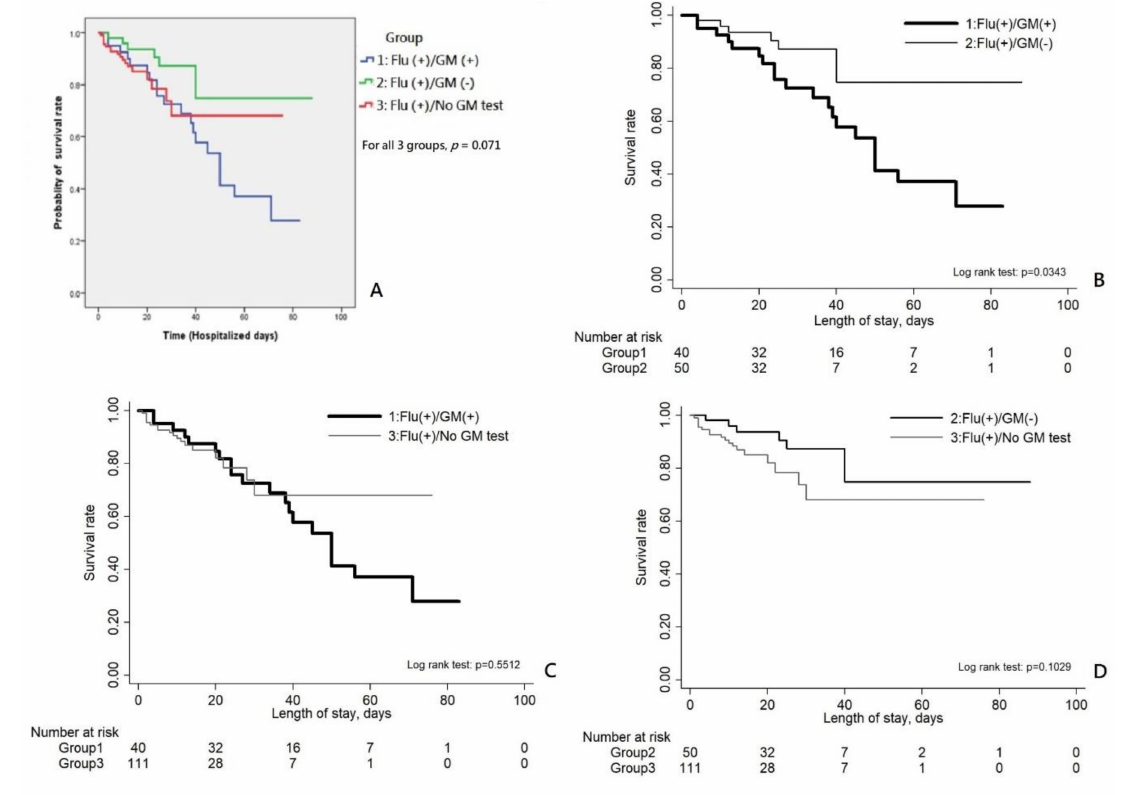
Figure 2. The overall survival using time-to-event analysis was lowest for group 1 of severely ill influenza patients with concomitant IPA among all three influenza groups ( p = 0.071, ( A )) with significant difference to group 2 with severe influenza only ( p = 0.034, ( B )). There was no significant difference between group 1 and group 3 ( p = 0.551, ( C )) and between group 2 and group 3 ( p = 0.103, ( D )). Note. Flu, influenza assay; GM, galactomannan assay; (+), positive result; (-), negative